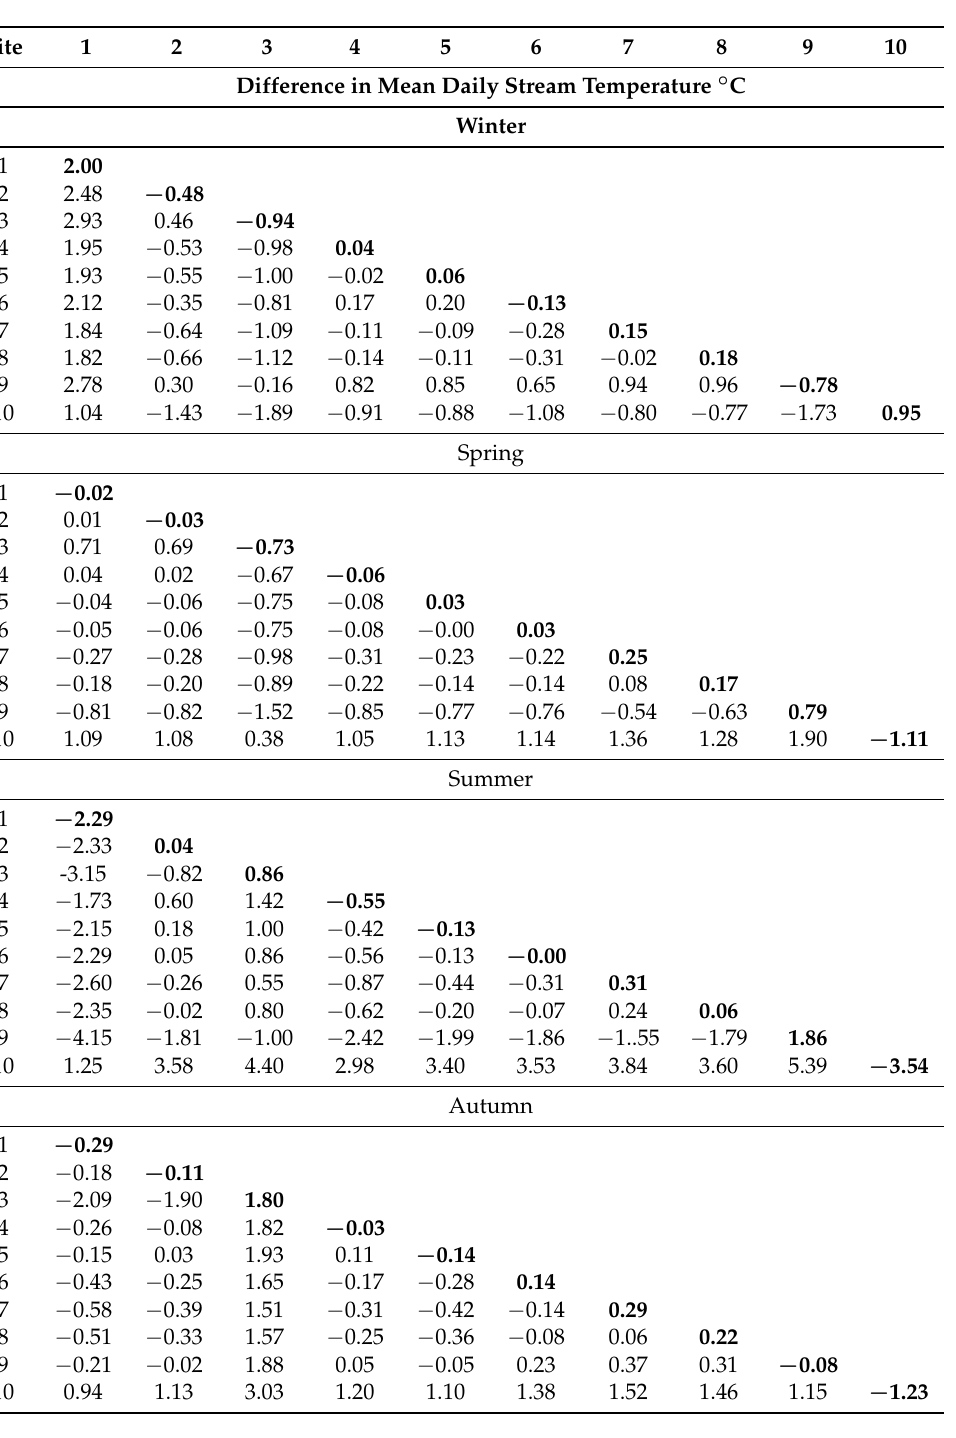
Table 6. Mean daily temperature anomaly ( ◦ C) at each site for each season. Diagonal of matrix (bold) is the temperature anomaly for the site based on all sites combined. Other values are the difference of the mean daily temperature anomaly between each site. Positive values indicate that the mean daily temperature at the site listed in the column is greater than the site listed in the row (all sites combined for bold values). All values were statistically significant ( p < 0.001); however, differences within ± 0.4 ◦ C are not considered physically significantly different due to the error in the data